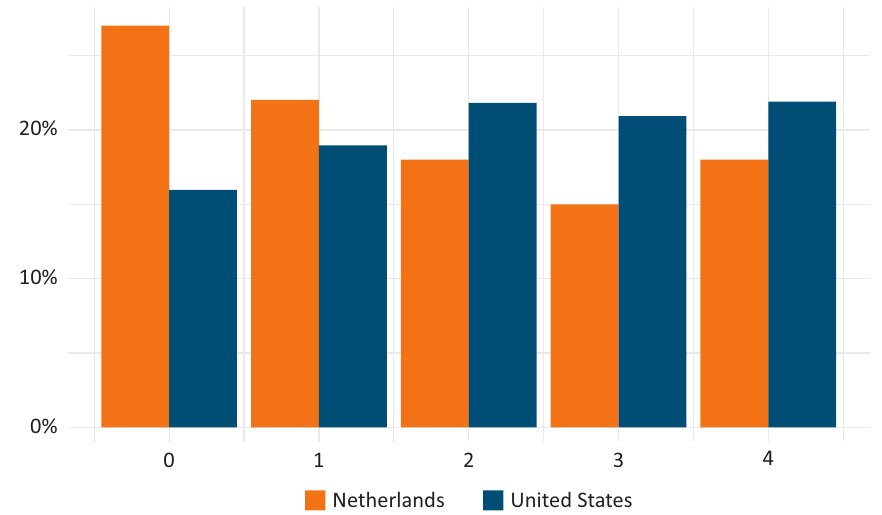
Figure 1. Descriptive information of the dependent variable. Notes: Mean = 1.92; SD = 1.43. Media and Communication, 2021, Volume 9, Issue 4, Pages